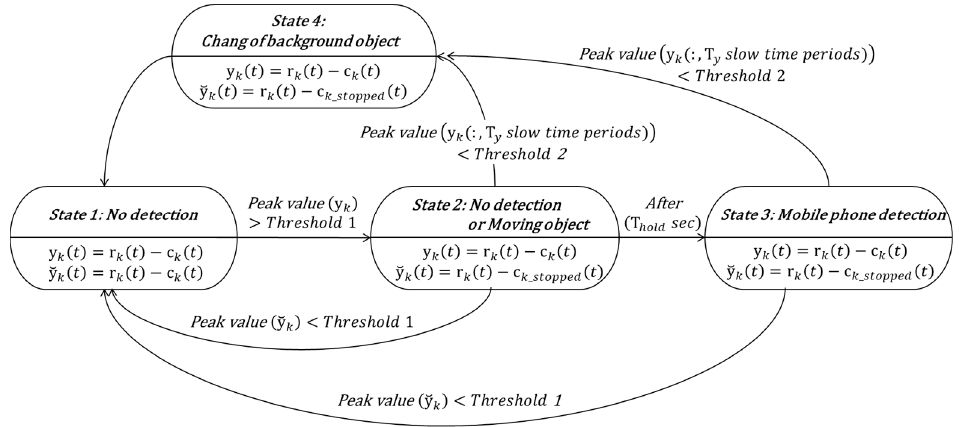
Figure 11. State diagram of dual-mode background subtraction algorithm for phone usage detection.